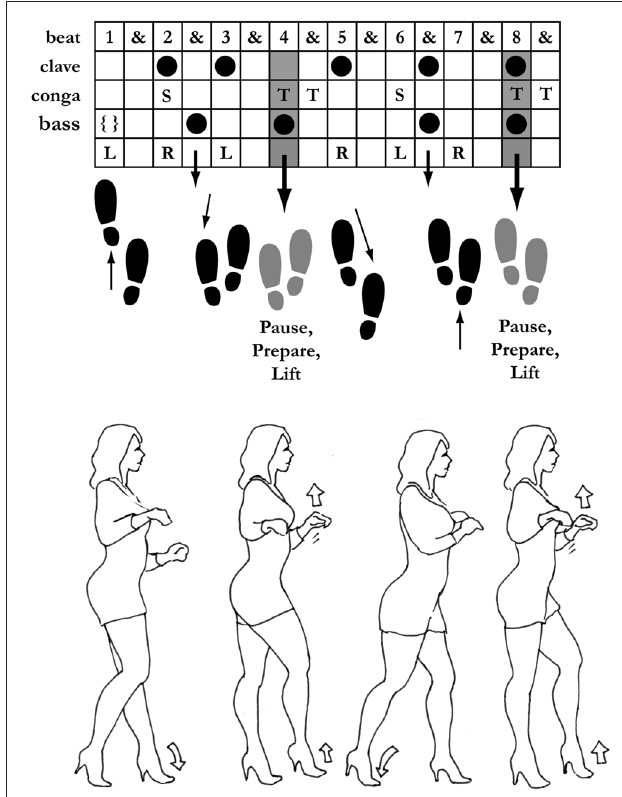
FIGURE 2 | Salsa dance and syncopation. The diagram illustrates a common version of the basic salsa step (“dancing on one”), synchronized with the instrumental parts to illustrate how a syncopated bass event (on the four) occurs during the upwardly-directed preparatory portion of the step, injecting acoustic energy into this upbeat (figure by the author). Downward arrows indicate syncopated bass notes; the { } indicates the absent bass (a rest) on the "one"